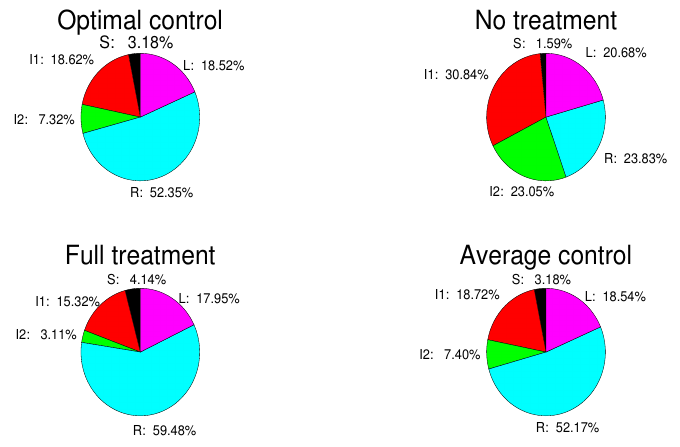
Figure 10. The diagram of proportion of nodes.